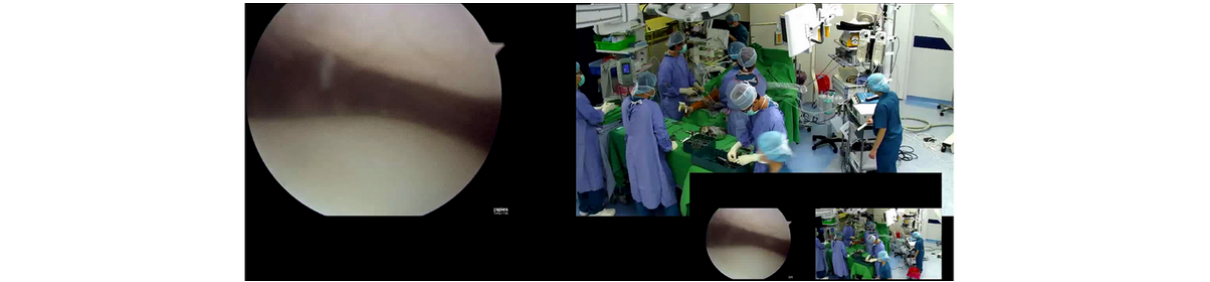
Figure 6. Demonstration of real-time streamed videos of arthroscopy and surgery